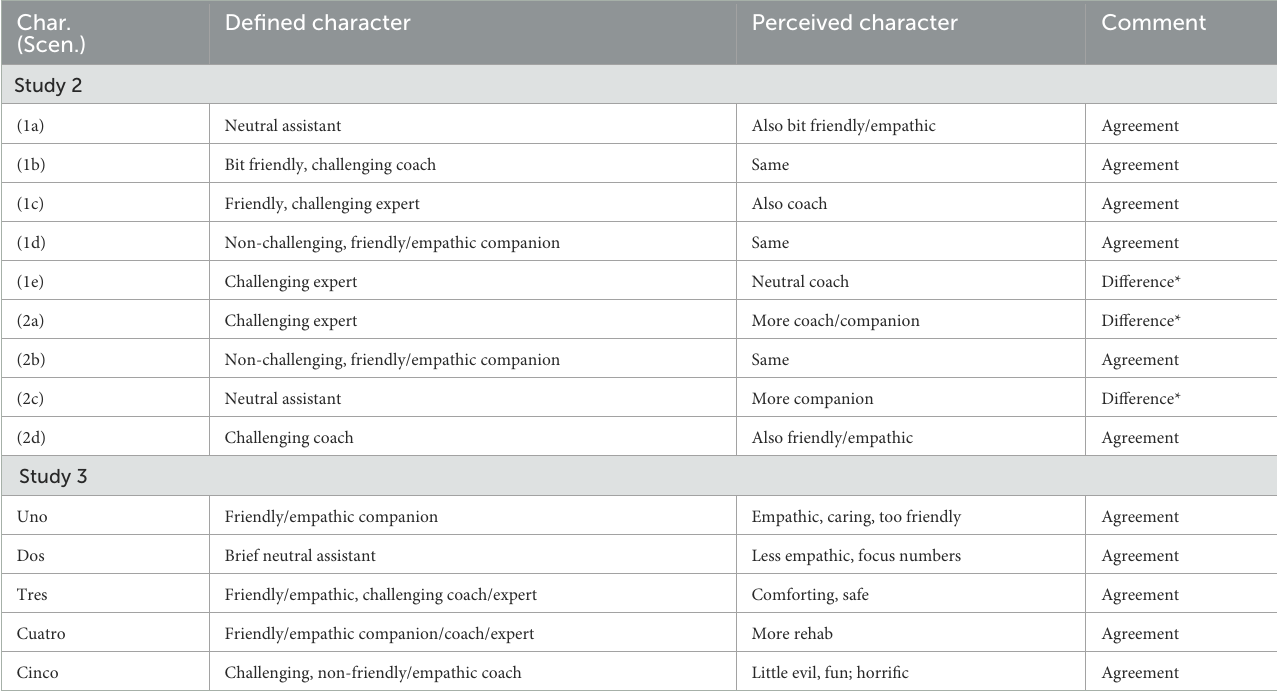
TABLE 6 Comparison of defined and perceived character and roles. Char.